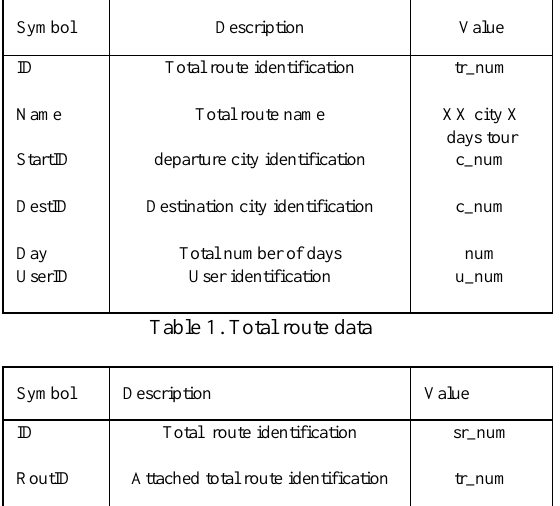
Table 1. Total route data